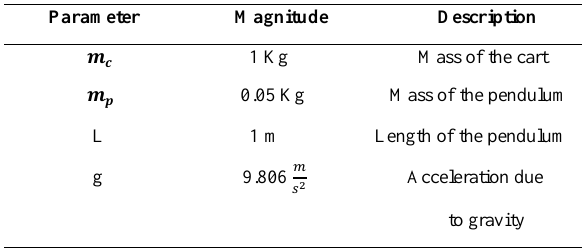
Table 1. The constant parameter’s magnitudes of the system.